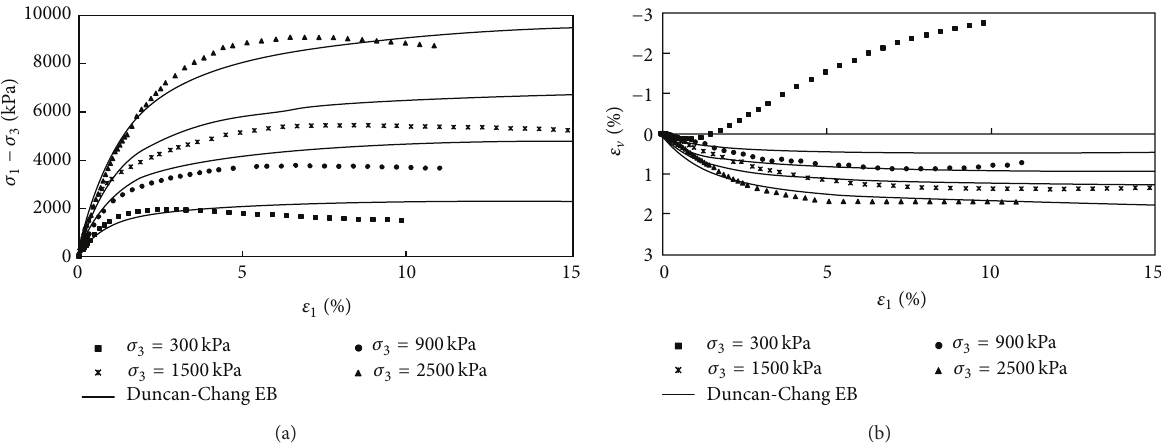
Figure 6: Comparison between fittings of Duncan and Chang’s EB model and experimental triaxial tests results for rockfill material II.